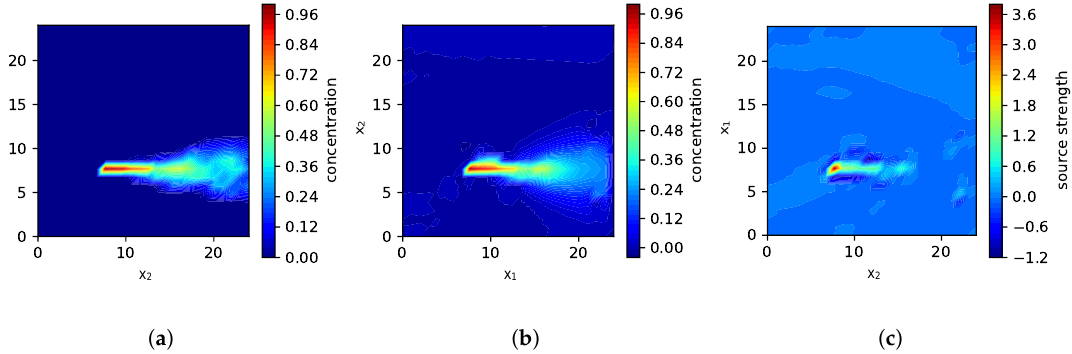
Figure 9. Exploration of a gas distribution simulated with mantaflow after 10 iterations (50 measurements): Plot ( a ) shows a snapshot of the instantaneous gas concentration field simulated by mantaflow. In ( b ) the estimated concentration field is shown and ( c ) depicts the estimated source